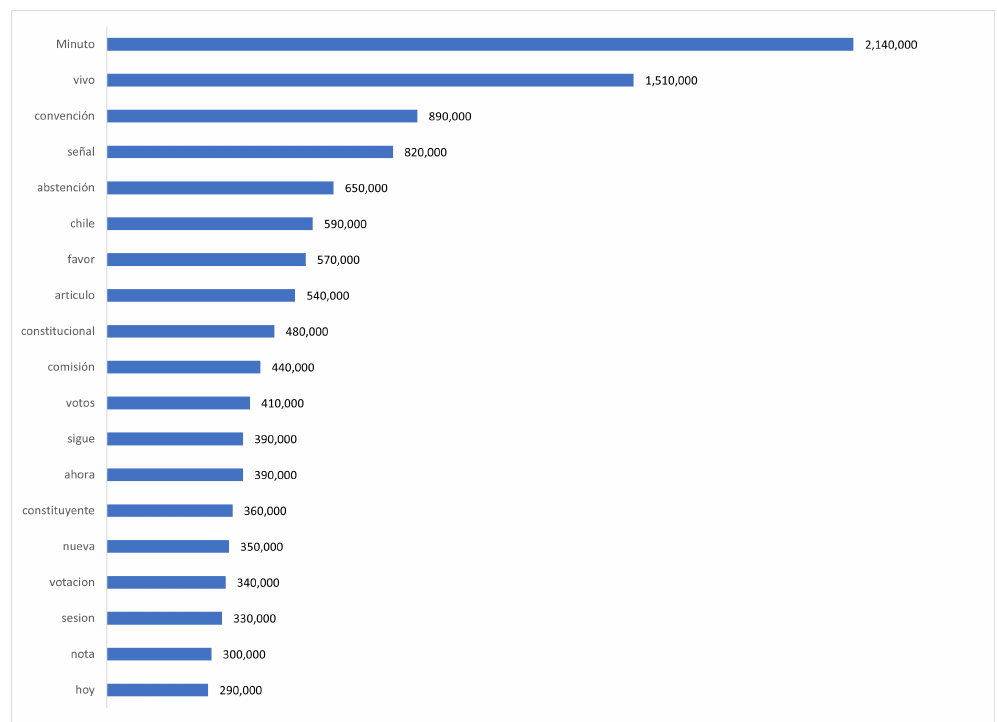
Figure 9. Top 20 popular words during the period January 2021–March